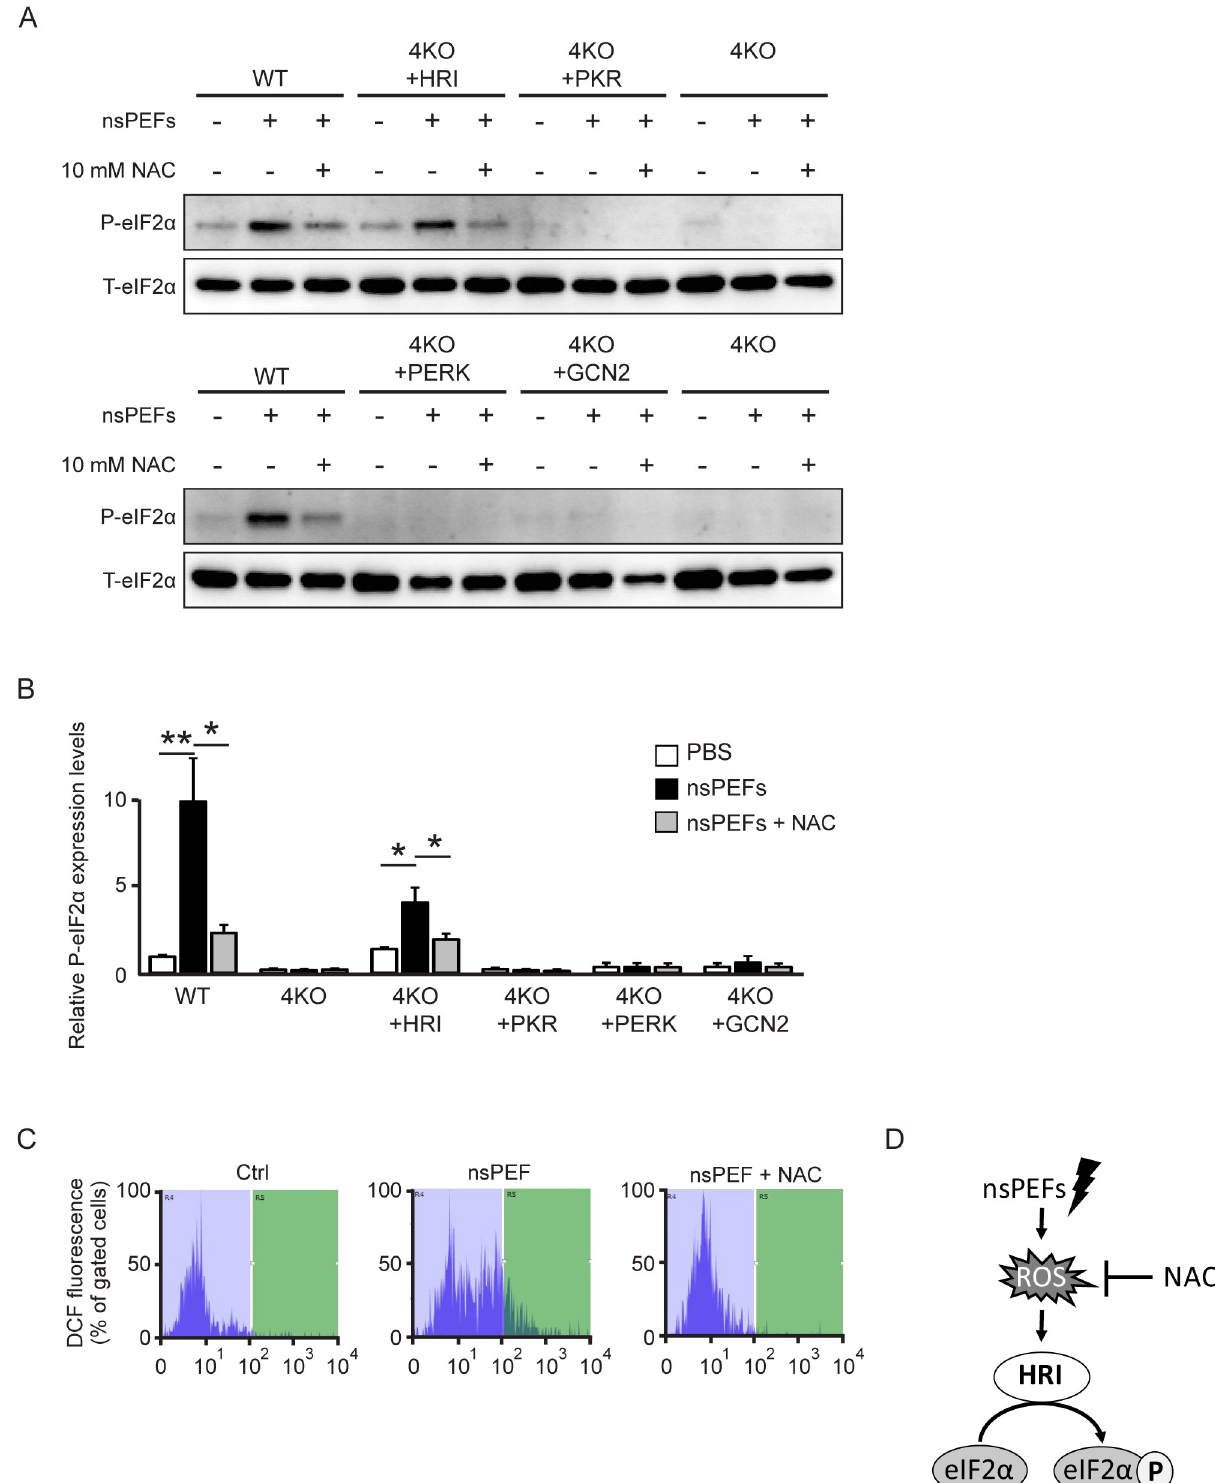
Fig 4. ROS-activated HRI phosphorylates eIF2 α during nsPEF treatment. ( A ) Representative immunoblots of phosphorylated eIF2 α and total eIF2 α in WT, 4KO and single eIF2 α kinase-rescued 4KO MEF cells 1 h after nsPEF treatment (40 shots of 70-ns duration and 30-kV/cm electric fields) with or without 10 mM NAC. ( B ) Densitometry quantification of phosphorylated eIF2 α normalized to the total eIF2 α level in WT, 4KO and single eIF2 α